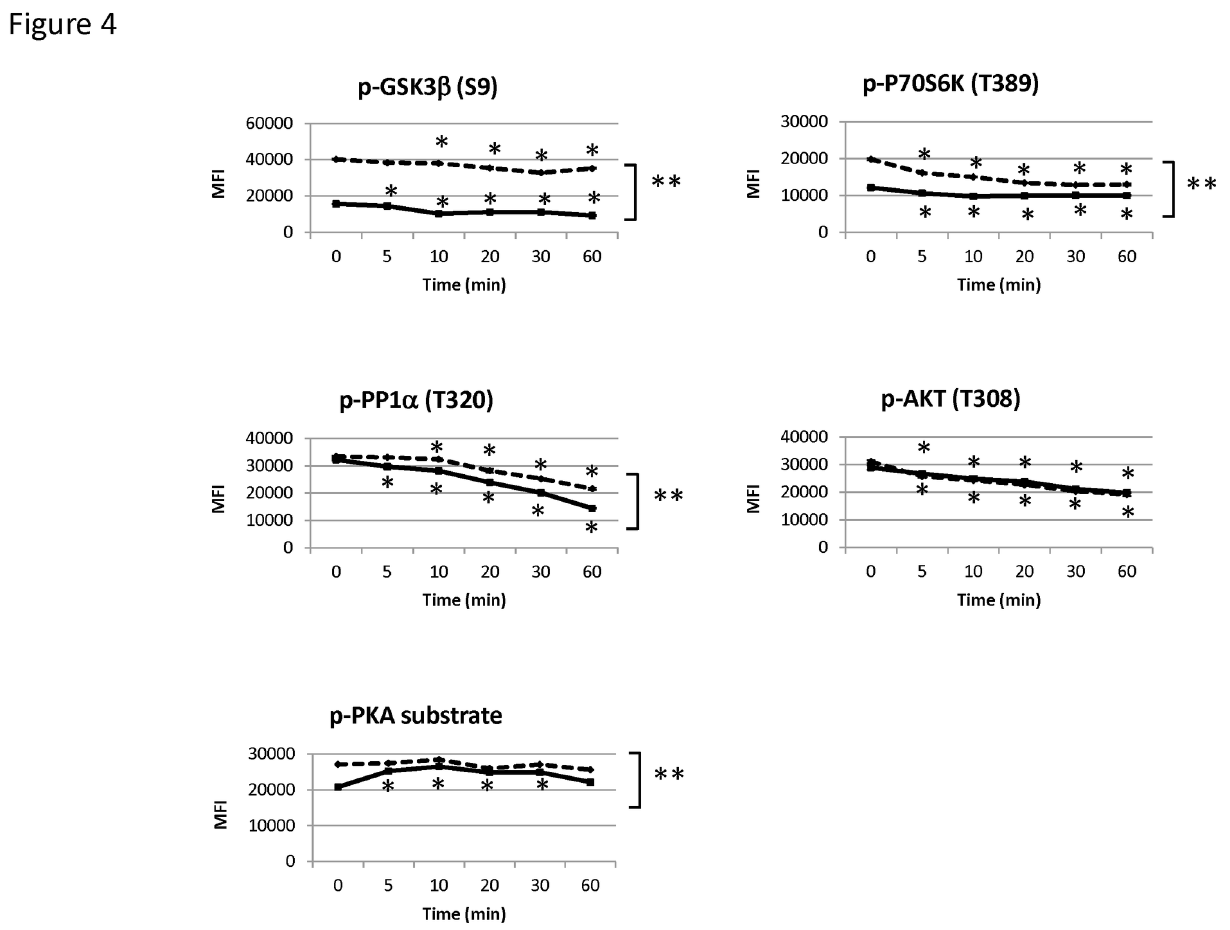
Figure 4. Isoproterenol-induced dephosphorylation events in the presence of okadaic acid. MEFs were pretreated with okadaic acid (1 μM) for 30 minutes and then were stimulated with isoproterenol (10 μM) for various times (0, 5, 10, 20, 30, or 60 minutes). Graphs show dephosphorylation of GSK3β(S9), P70S6K(T389), PP1α(T320), and AKT(T308) after the addition of isoproterenol in the presence (dashed line) or absence (solid line) of okadaic acid. The basal levels of phosphorylation of GSK3β(S9), P70S6K(T389), and PKA substrate were increased by okadaic acid at the unstimulated (0 minute) time point. Values in graphs are median ± S.D fluorescence intensity (MFI). of lysate microarray features. ** denotes a significant difference (P<0.05) from okadaic acid treatment as determined using a one-way ANOVA with repeated measures. * denotes significant difference (P<0.05) from the baseline time point as determined using a Dunnett post-hoc